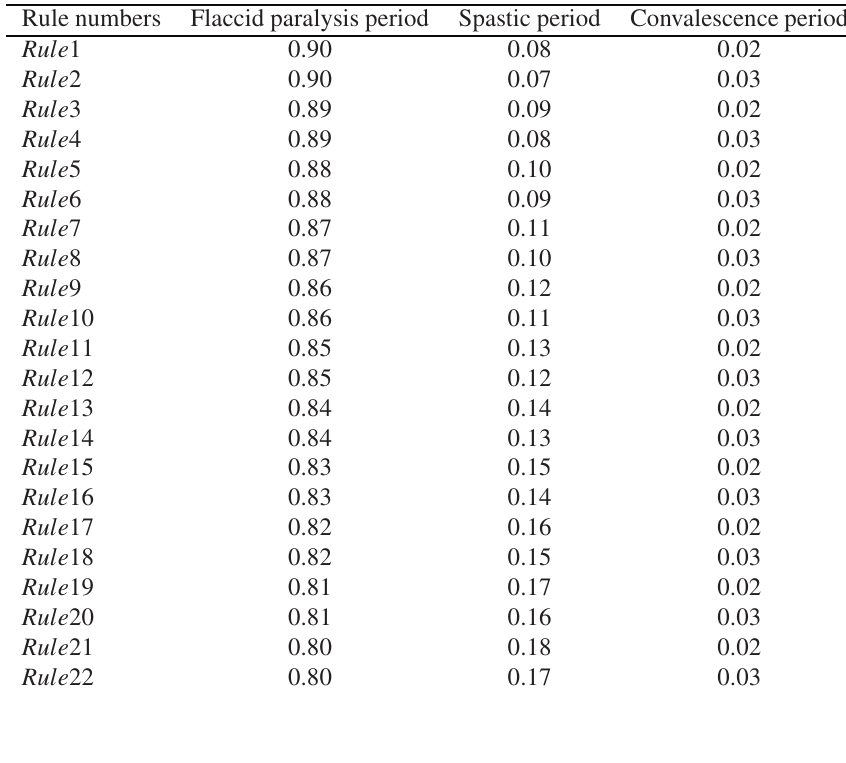
Table A.2. The initial belief degree of consequent